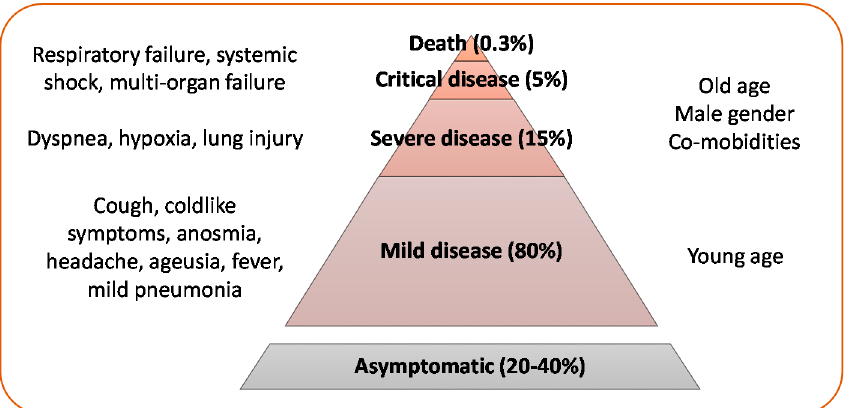
Figure 1. Clinical presentation of SARS-CoV-2 infection: About 20–40% of SARS-CoV-2 infections are asymptomatic, especially in young individuals [10–13]. Mild symptoms are reported in about 80% of symptomatic infections (with or without mild pneumonia), severe disease in about 15%, critical disease in 5% [14]. The risk of death from SARS-CoV-2 infection has been estimated as 0.3% [15]. Elderly age, male gender, and presence of co-morbidities are risk factors for severe disease [16,17].